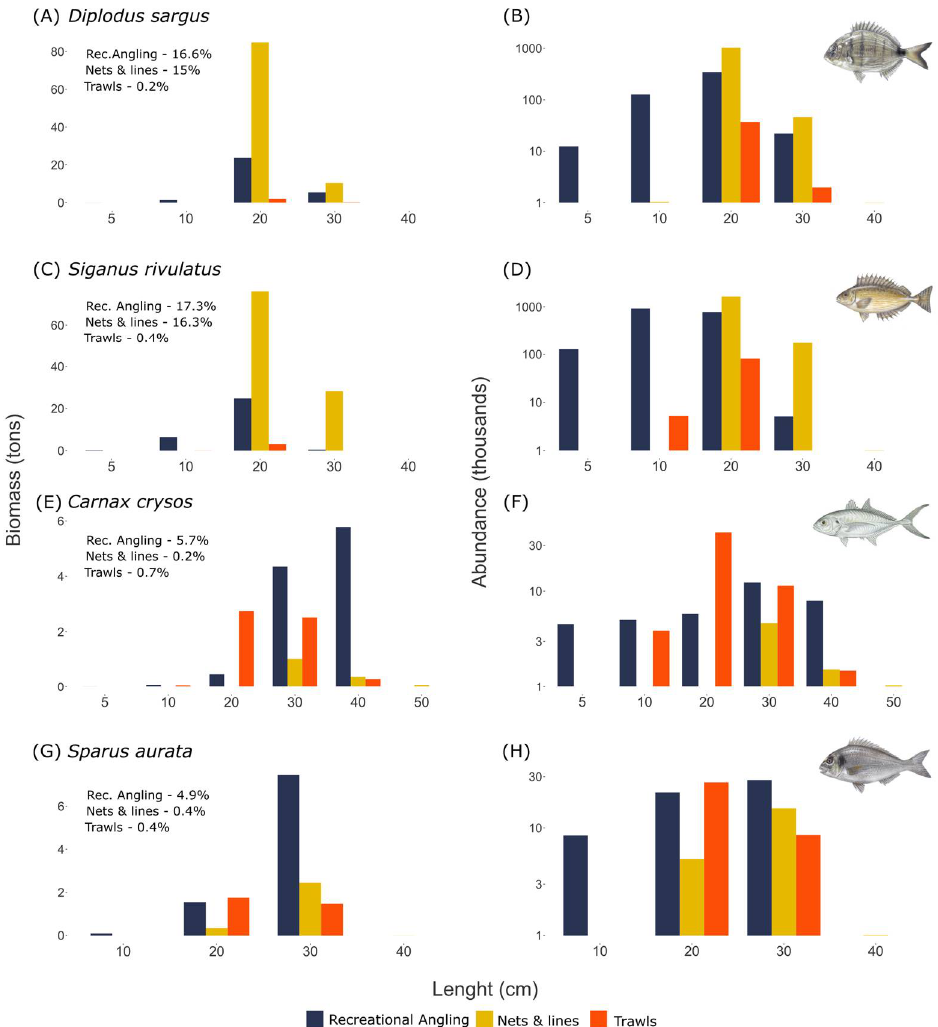
Figure 4. ( A – H ) Common species caught by recreational angling from shore (blue), nets and long- lines (yellow), and trawl fishing (orange). Figures are divided into biomass and abundance for each species. Species were divided by length into size bins, as shown on the x axes. The bottom key shows the proportion each species represents from the total catch of the method (in %). For all species results see Figure S5 and Tables S12 and S13.